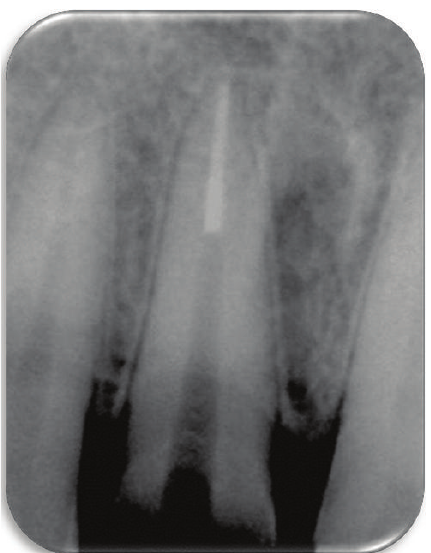
Figure 6: Post space